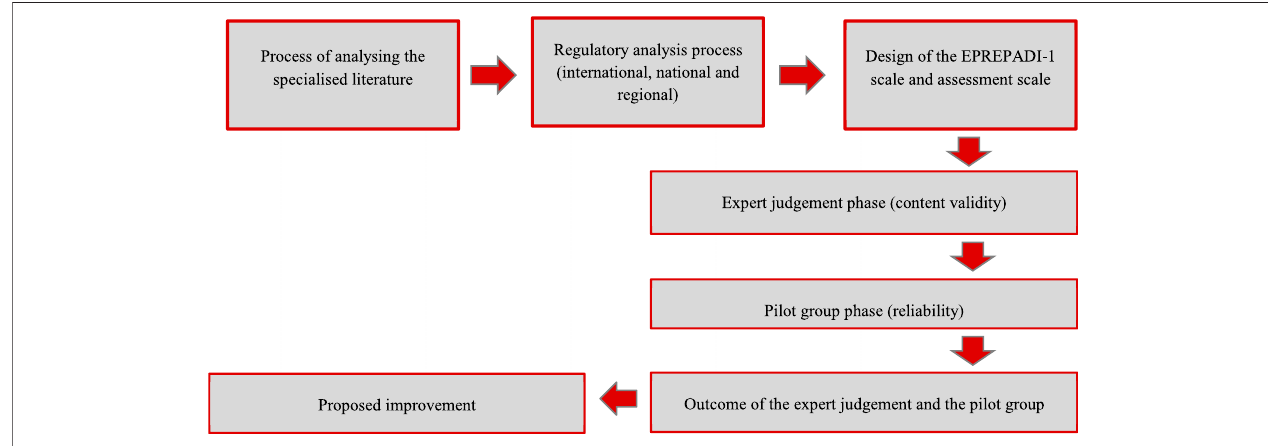
FIGURE 1 | Itinerary of the validation process of the EPREPADI-1 scale. Source: Own